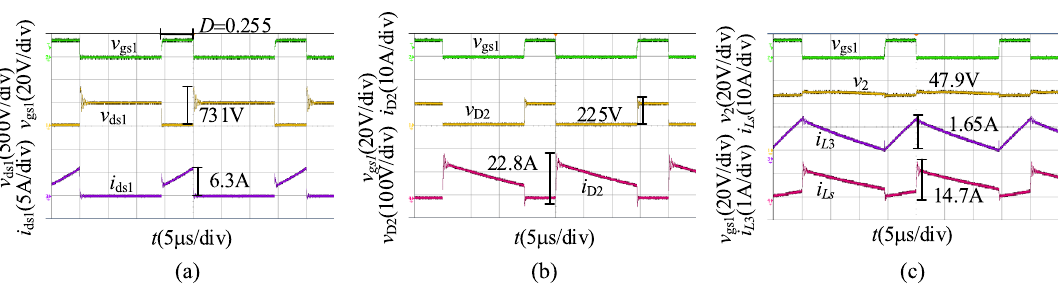
Figure 22. The experiment results of the proposed converter in the step-down mode when v 1 = 400 V: ( a ) v gs1 , v